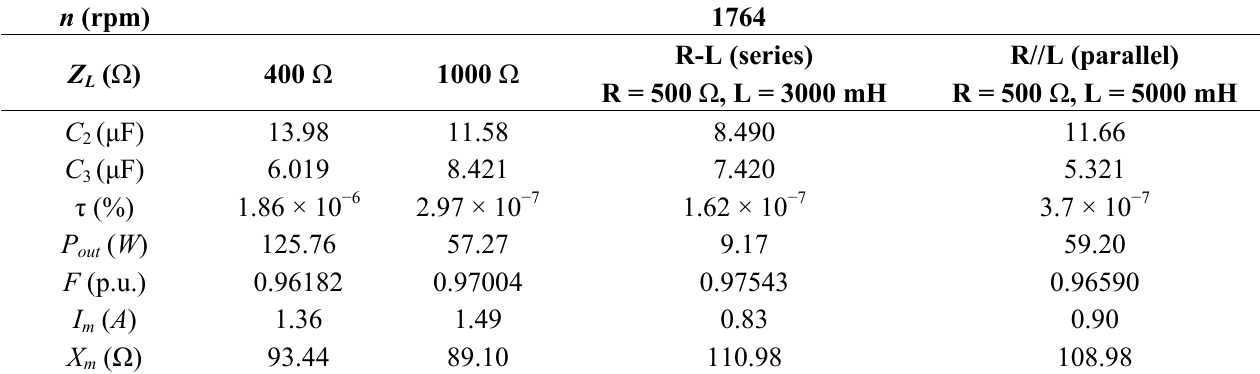
Table 1. Capacitance values C different load impedances at a rotating speed of n = 1764 rpm.